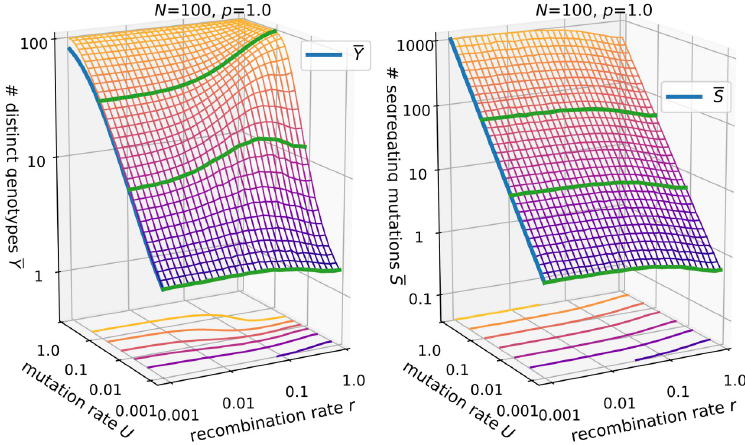
Fig 15. Number of distinct genotypes and segregating mutations in the simple successive recombination model for the ism . Parameters are N = 100, p = 1. Compare to Figs 4 and 5. Green lines show constant U = 0.1, U = 0.01 and U =